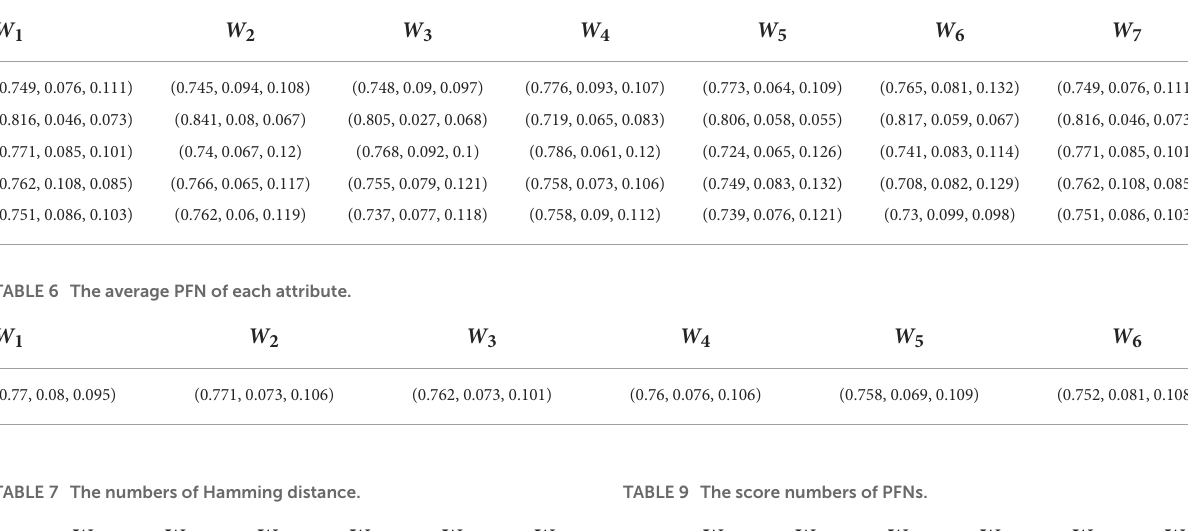
TABLE 5 The integrated and normalized decision matrix.